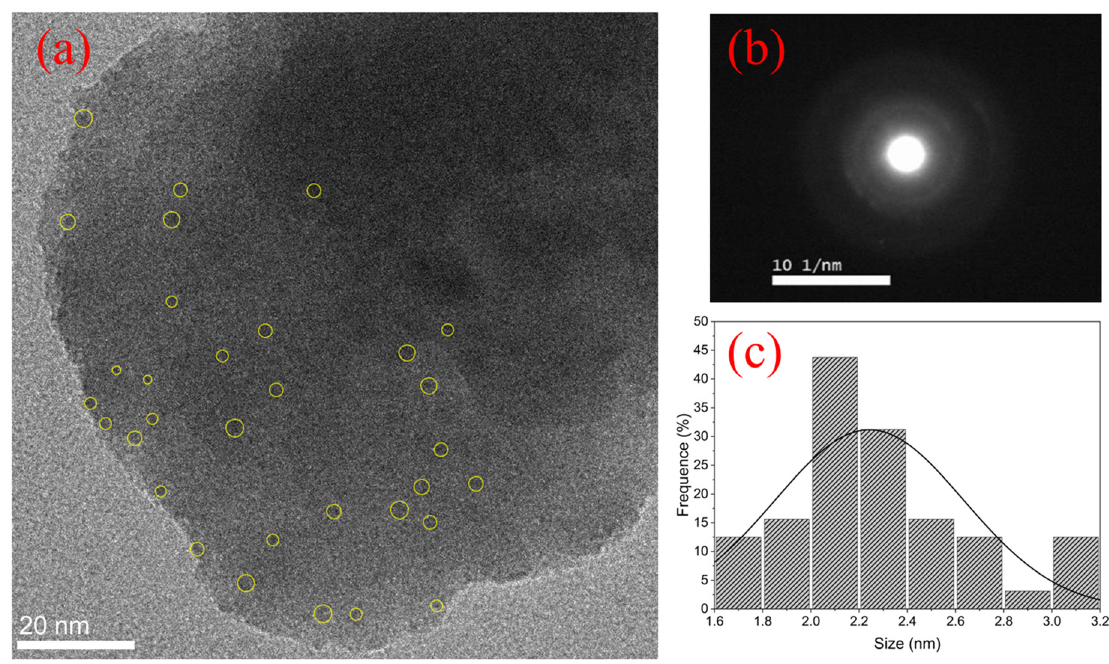
Figure 12. ( a ) TEM image of the GP 4.5Ag4.5Yb sample, ( b ) ED pattern, and ( c ) size distribution.